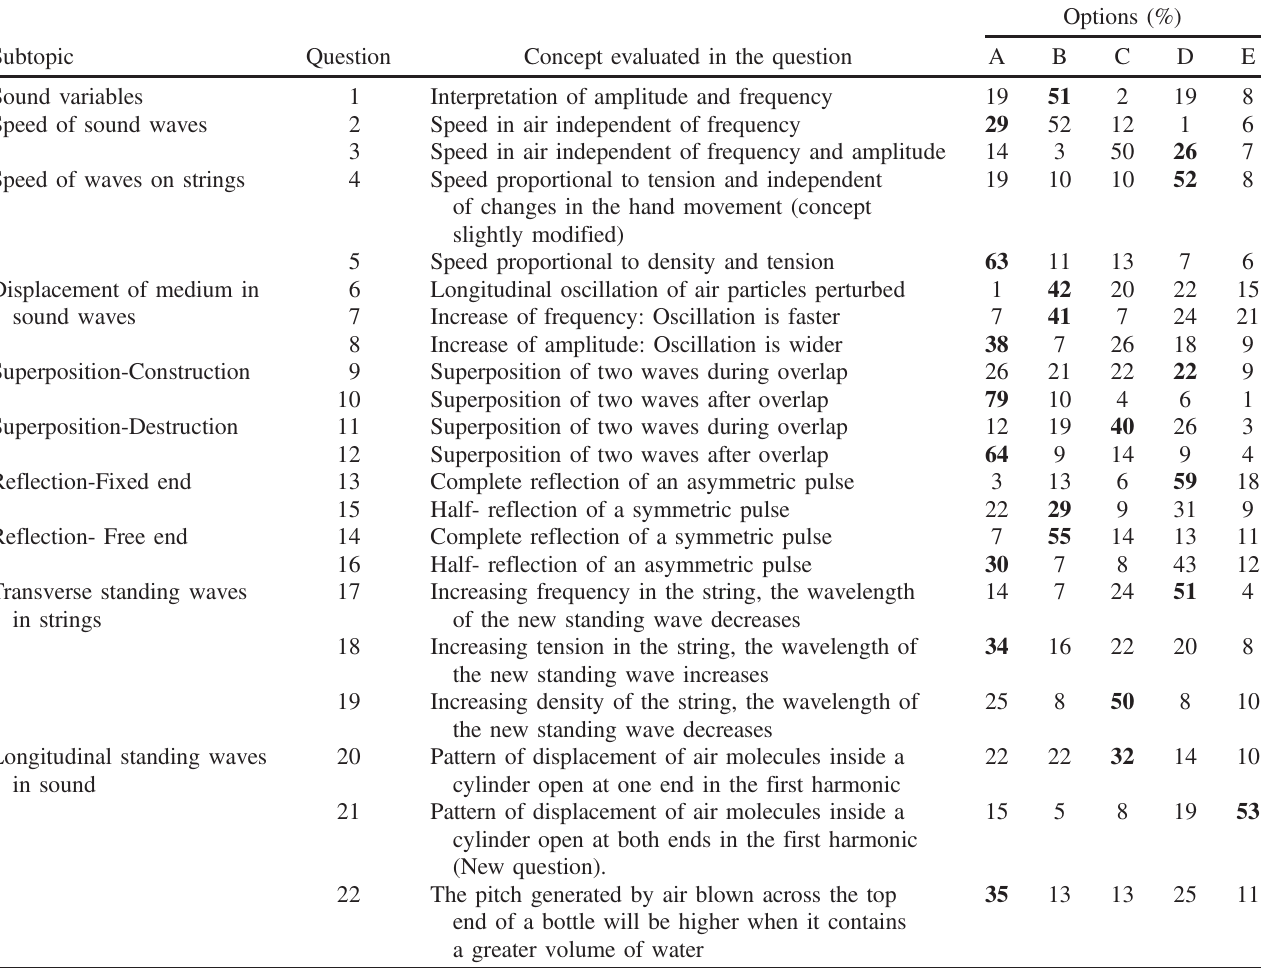
TABLE III. Results obtained on the modified MWCS. The correct answer is in